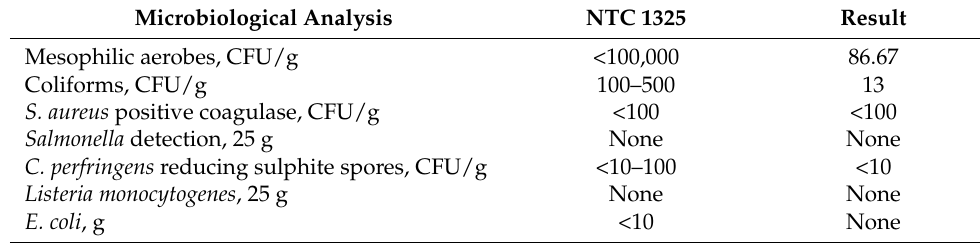
Table 7. Microbiological meatball